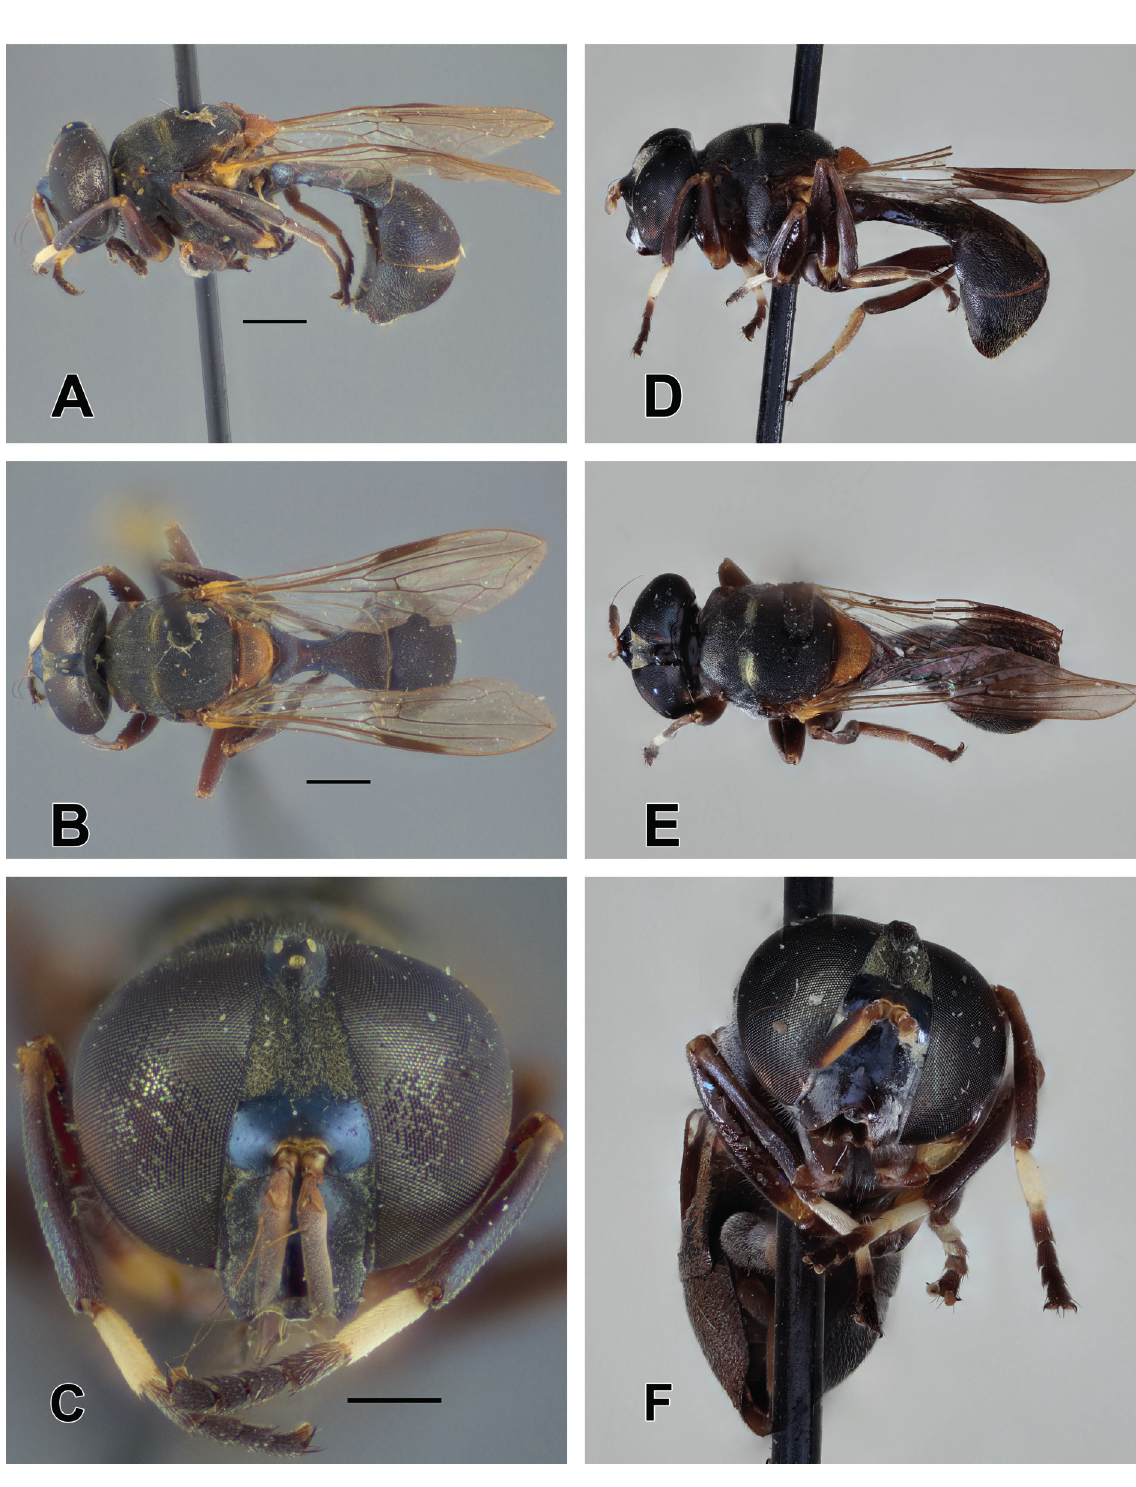
Fig. 6. A–C . Myolepta petiolata Thompson, 1971, ♀ (ZFMK-DIP-00082511). A . Habitus, lateral view. B . Habitus, dorsal view. C . Head, frontal view. D–F . M. petiolata , ♀, holotype (BPBM). D . Habitus, lateral view. E . Habitus, dorsal view. F . Habitus, frontal view. Scale bars: A–B = 1 mm; C = 0.5